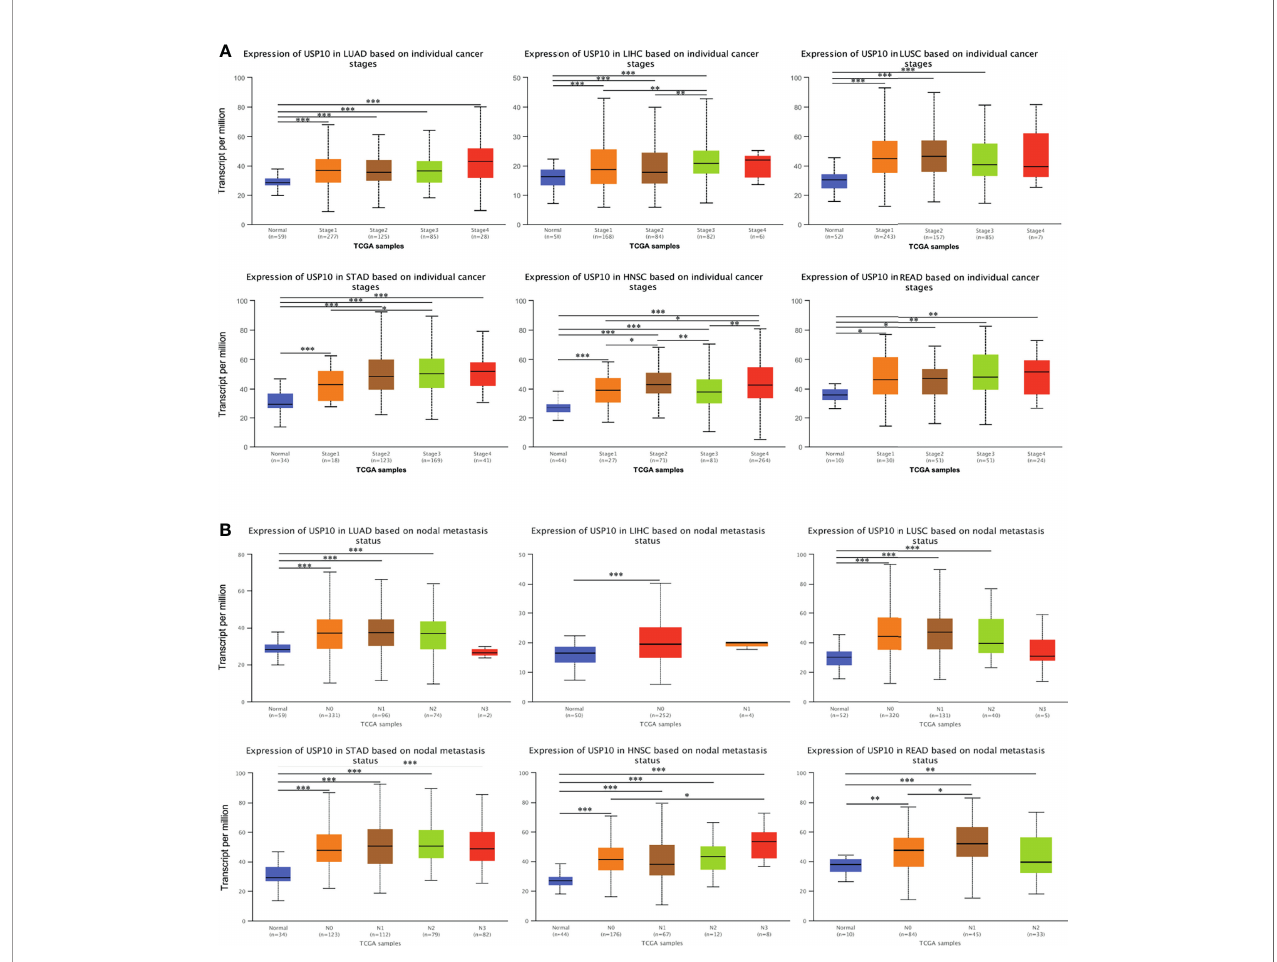
FIGURE 7 | UALCAN database analysis of correlation between clinicopathological parameters and USP10 expression in multiple cancer types. (A) Association between USP10 expression and tumor stages in patients with different types of cancer. (B) The association between USP10 expression and nodal metastasis status in patients with different types of cancer. LUAD, lung adenocarcinoma; LIHC, liver hepatocellular carcinoma; LUSC, lung squamous cell carcinoma; STAD, stomach adenocarcinoma; HNSC, head and neck squamous cell carcinoma; READ, rectal adenocarcinoma. * P < 0.05; ** P < 0.01; *** P <